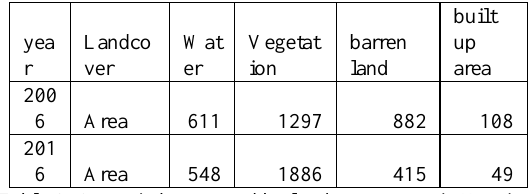
Table 3: Areas in ha covered by landcover types in Nurri